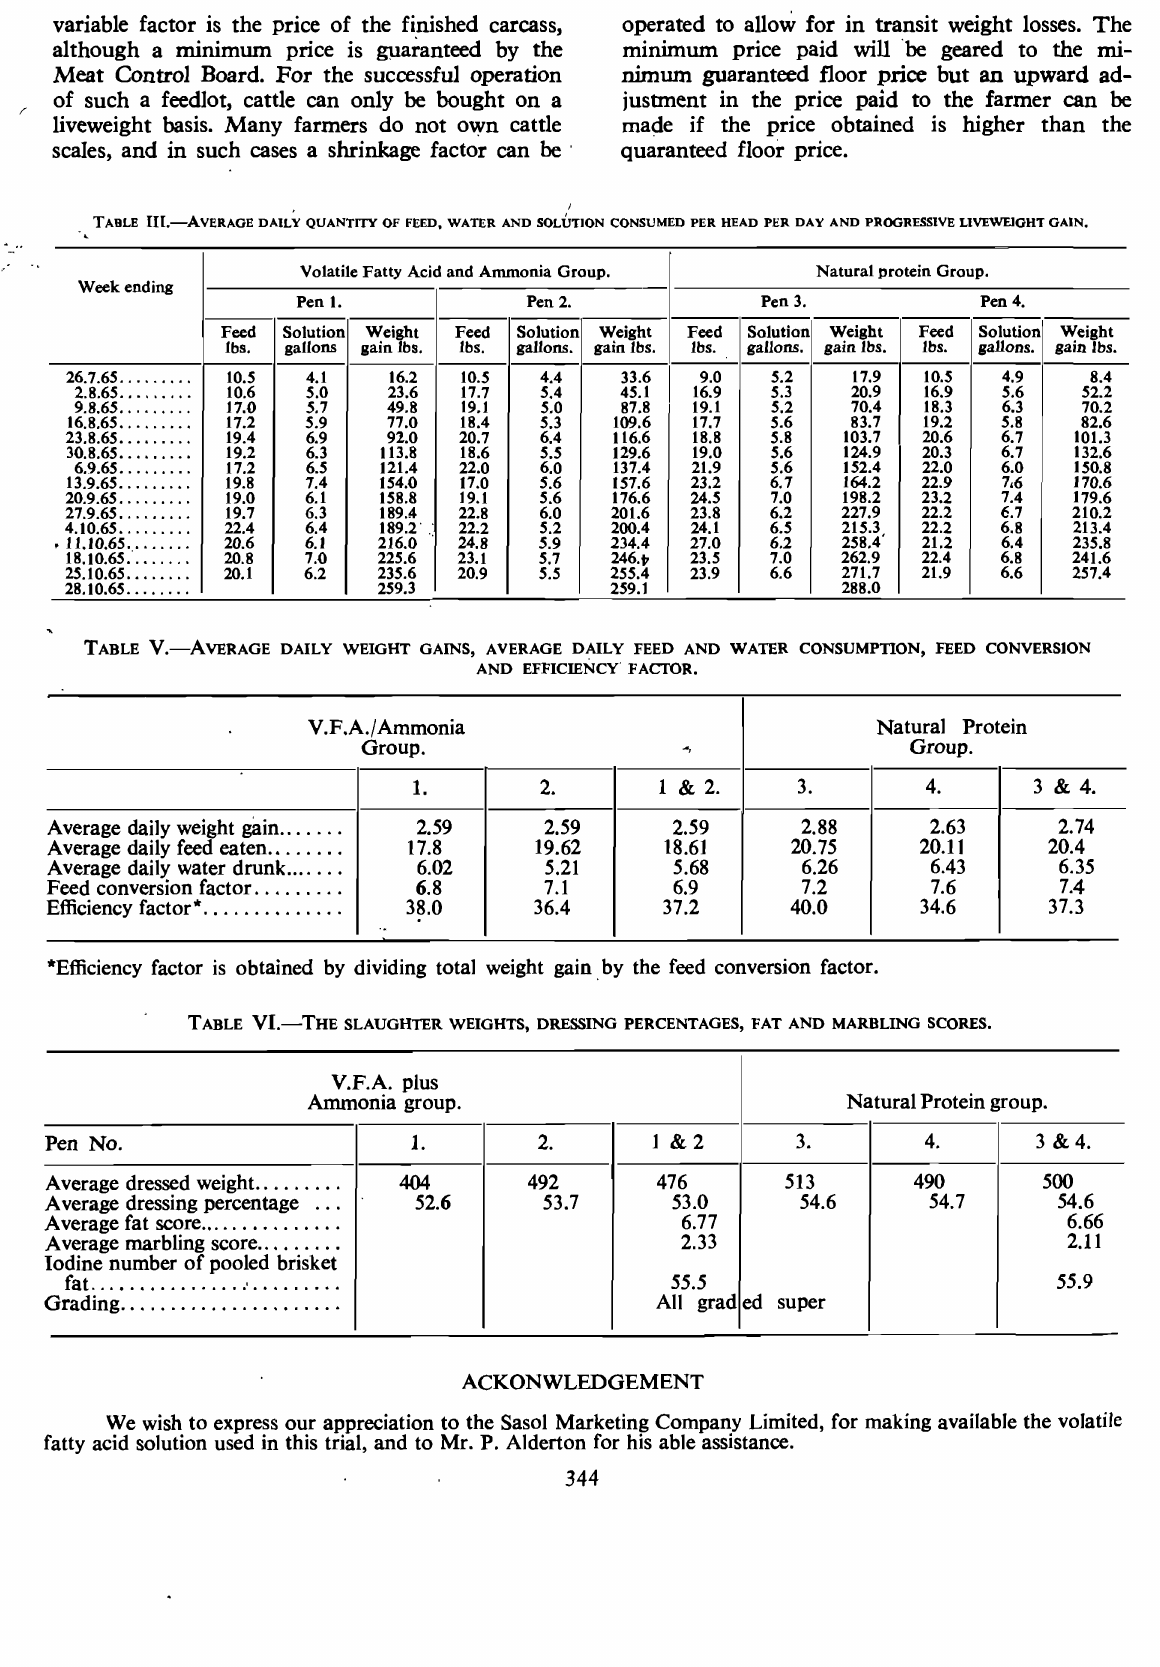
TABLE V.-AVERAGE DAILY WEIGHT GAINS, AVERAGE DAILY FEED AND WATER CONSUMPTION, FEED CONVERSION AND EFFICIENCY FACTOR.